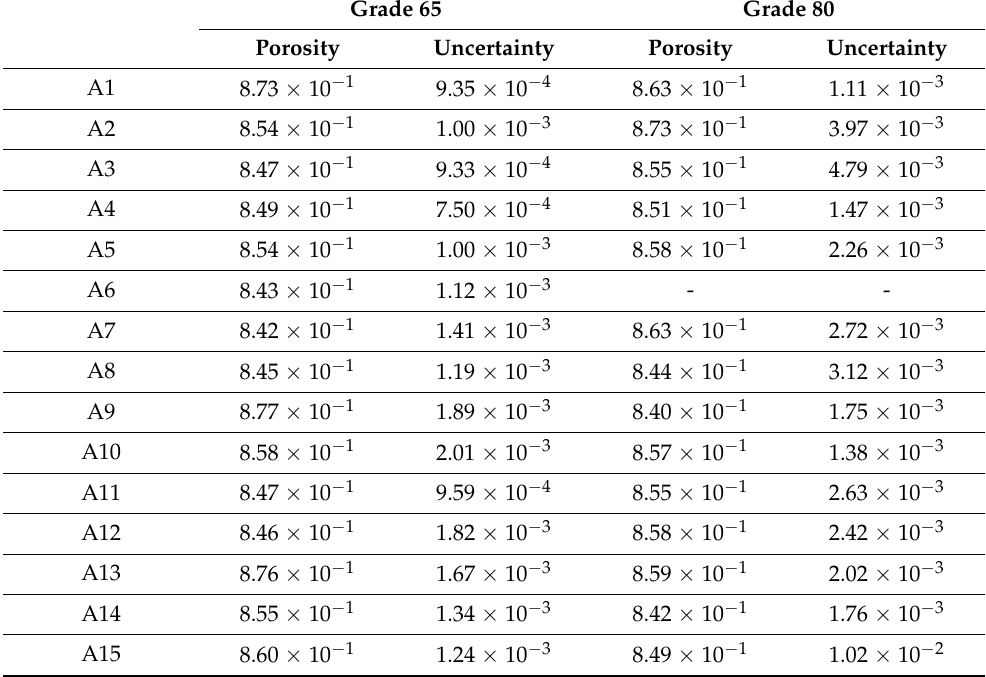
Table A2. The porosity of CFF samples of Grade 65 and Grade 80 from supplier A.